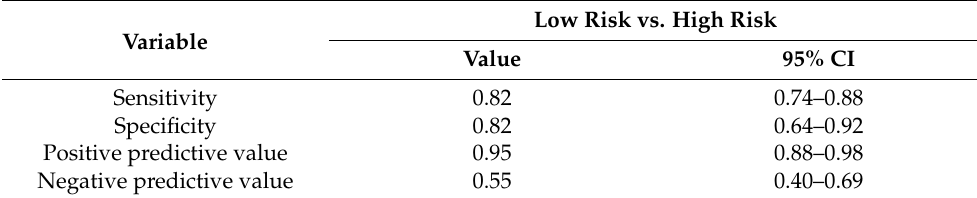
Figure 3. ( A ) Predictive value of the ECG score for cardiotoxicity determined using the ROC analysis. ( B ) Incidences of cardiotoxicity increase with increasing score values. ** p < 0.01, *** p < 0.001. Table 3. Sensitivity analysis for the prediction of cardiotoxicity.